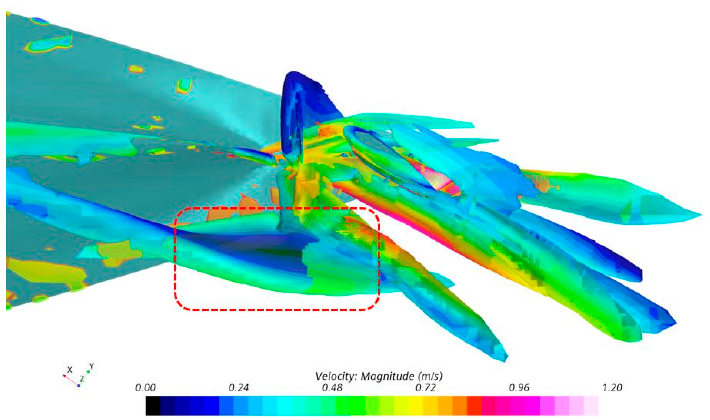
Figure 21. Tail vortex at t = 10 s.